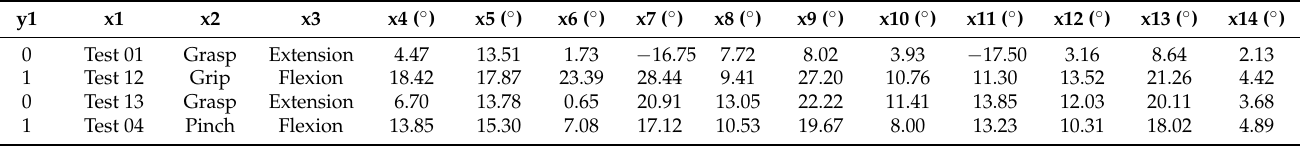
Table 1. Dataset